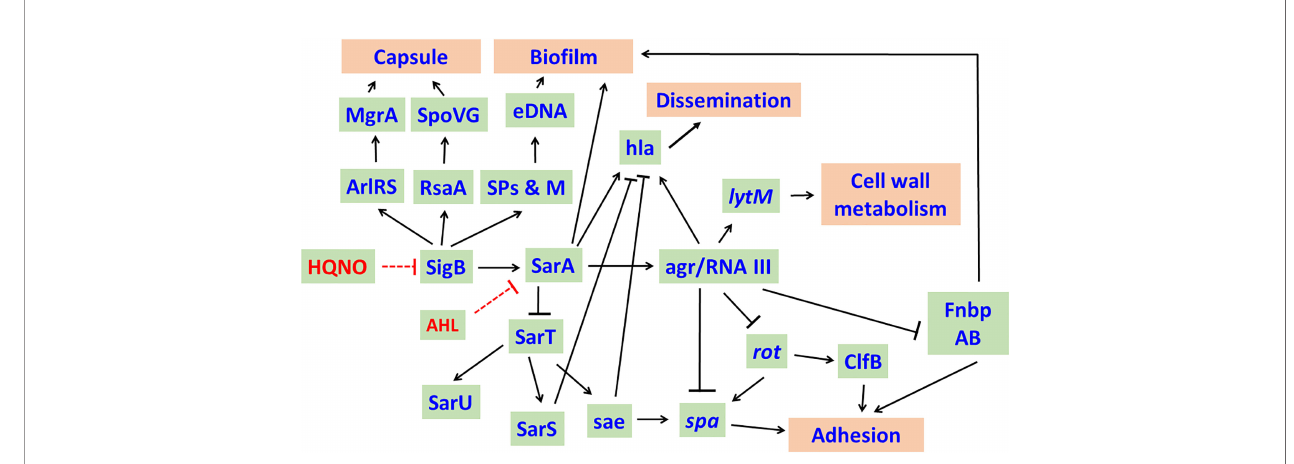
FIGURE 2 | Effect of Long chain - acyl homo serine lactones (AHLs) of P. aeruginosa on S. aureus . In general, SigB and SarA regulate the expression of a number of genes and their products and enhance the virulence of S. aureus . AHLs of P. aeruginosa target SigB and SarA and cause decreased transcription of sigB , sarA and agr RNAIII resulting in decreased capsule production, bio fi lm formation and dissemination. Inhibition of agr RNAIII enhances the production of Protein A, ClfB, FnbpAB, which increase the adhesion of S. aureus to host cells. RpiRc regulates RsbU to modulate eDNA-dependent bio fi lm formation and in vivo virulence of S. aureus in a mouse model of catheter infection. The network was drawn based on the knowledge acquired from literature (Schmidt et al., 2003; Tamber and Cheung, 2009; Fechter et al., 2014; Andrey et al., 2015). Arrows represent activation while bars represent repression. SPs & M, Secreted proteins & metabolites; eDNA, extracellular DNA; ClfB, clumping factor B; FnbpAB, Fibronectin binding proteins A and B; spa , Protein A; hla , alpha-toxin; sae , S. aureus